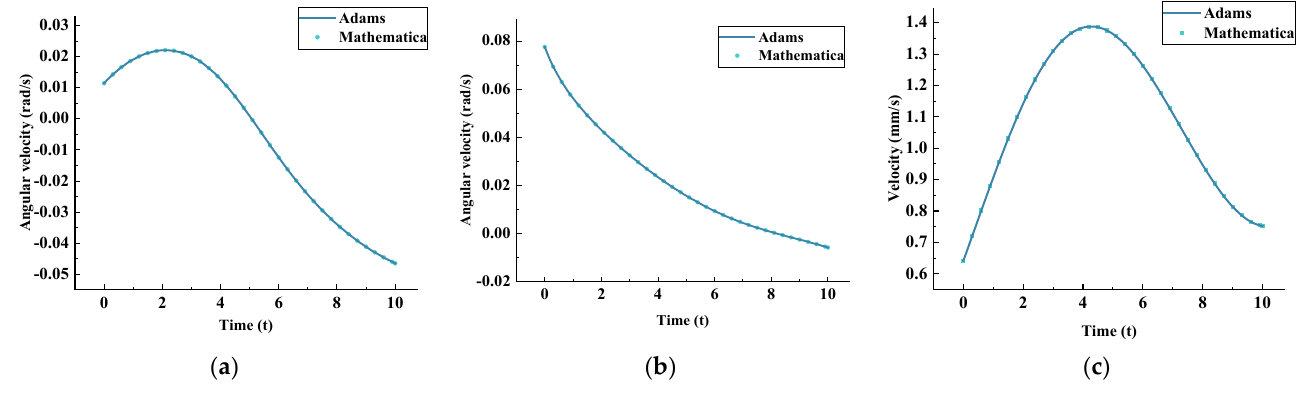
 ; ( h  . c )  ; ( h  . Figure 5. Comparisons of input velocity curves theory and simulation results: ( a ) . ϕ ; ( b ) . φ ; ( c ) . h 3 c ) 3 3